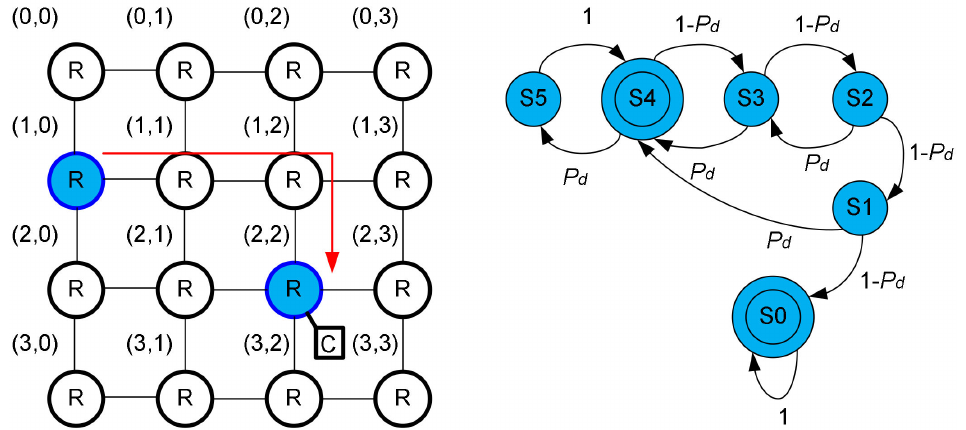
Figure 1. A 4 × 4 NoC mesh, with source − destination pair and corresponding Markov chain. Initial state is S4 (3 hops plus flit ejection) and absorbing state is